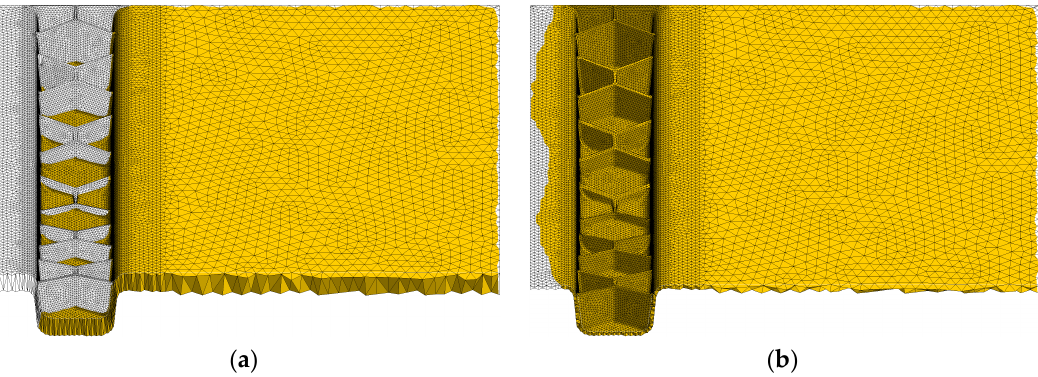
Figure 7. Mold filling simulation in 3D TIMON CompositePRESS using the morphing method; ( a ) cross sectional view of the morphed tetra mesh in the initial open-mold position; ( b ) pressed back tetra mesh close to end of compression showing the proceeding flow front in the hat brim.